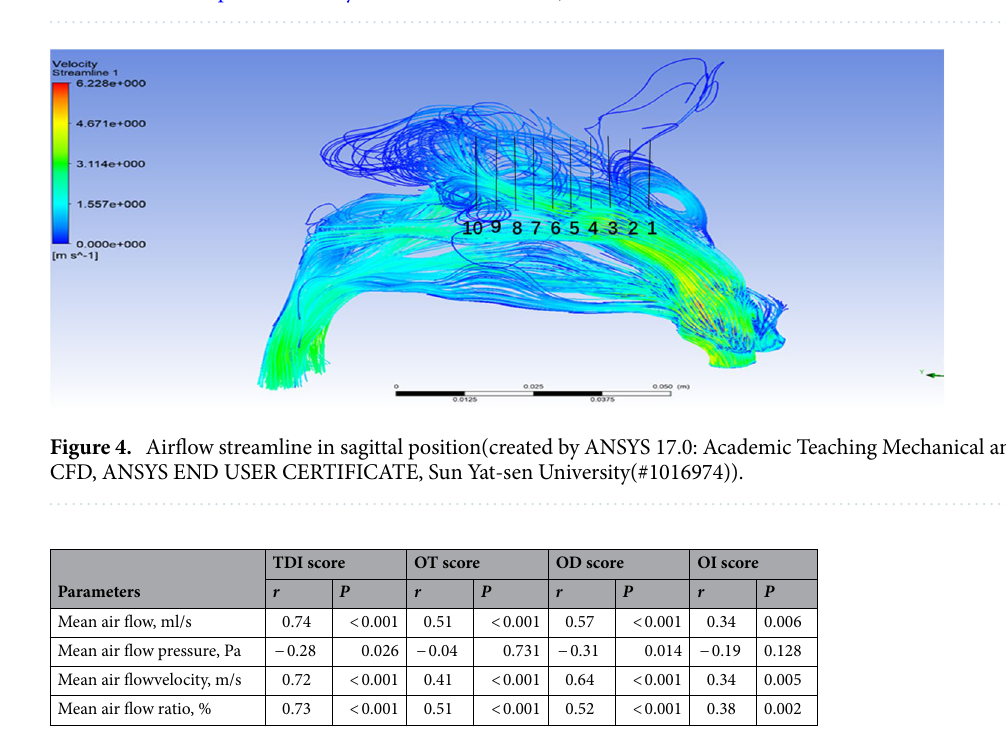
Figure 3. Range of statistical values of fluid characteristic parameters in the olfactory cleft region (created by Matlab R2021a, https:// softw are. sysu. edu. cn/ matla bhome).